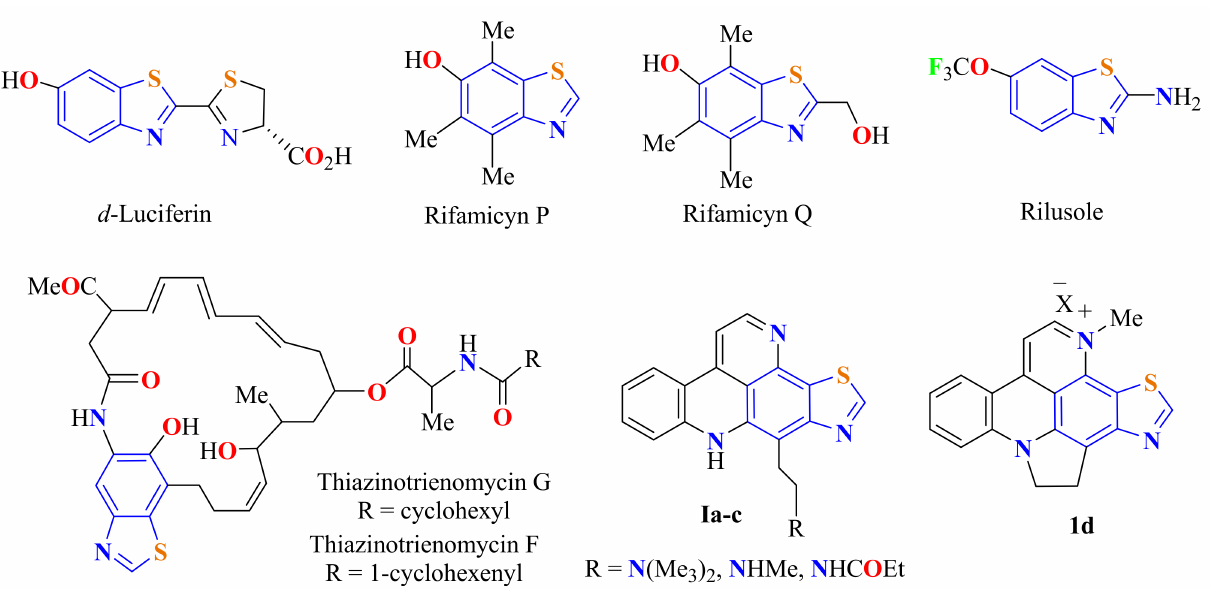
Figure 1. Benzothiazole ring core in natural compounds with pharmaceutical applications.